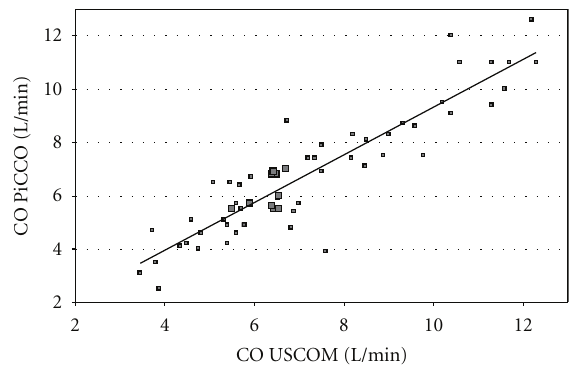
Figure 1: Correlation of CO measurements by USCOM and PiCCO (median CO USCOM 6.55 L/min ± 2.19, median CO PiCCO 6.5L/min ± 2.18; r = 0 . 89) (increased size of points which are multiples).